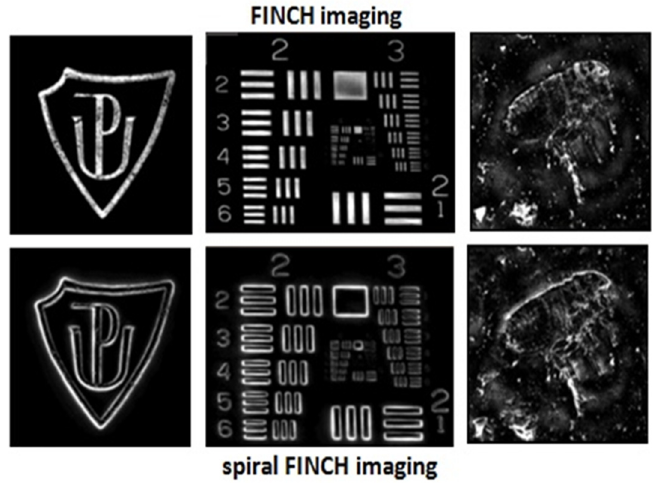
Figure 17. Imaging of the Palacký University sign, USAF test, and flea created using FINCH and spiral FINCH under incoherent illumination.